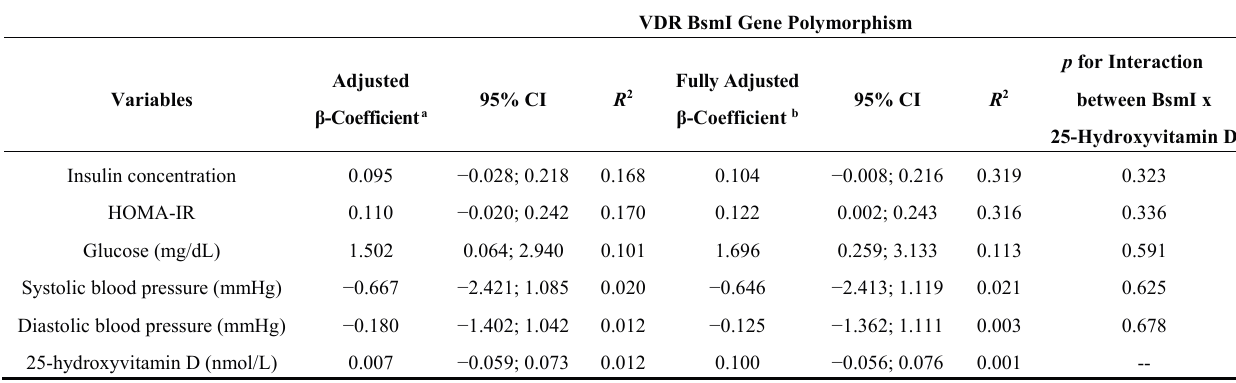
Table 4. Association of Vitamin D receptor (VDR) BsmI gene polymorphism with metabolic parameters (Acrelândia, Brazil,